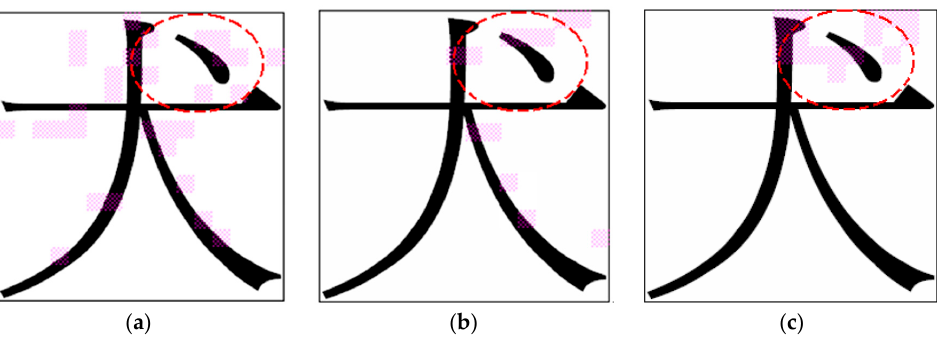
Figure 12. Feature vectors selected by ( a ) IG; ( b ) SFFS; ( c ) NRFS. Table 7. Experimental results of original data set of Chinese characters.